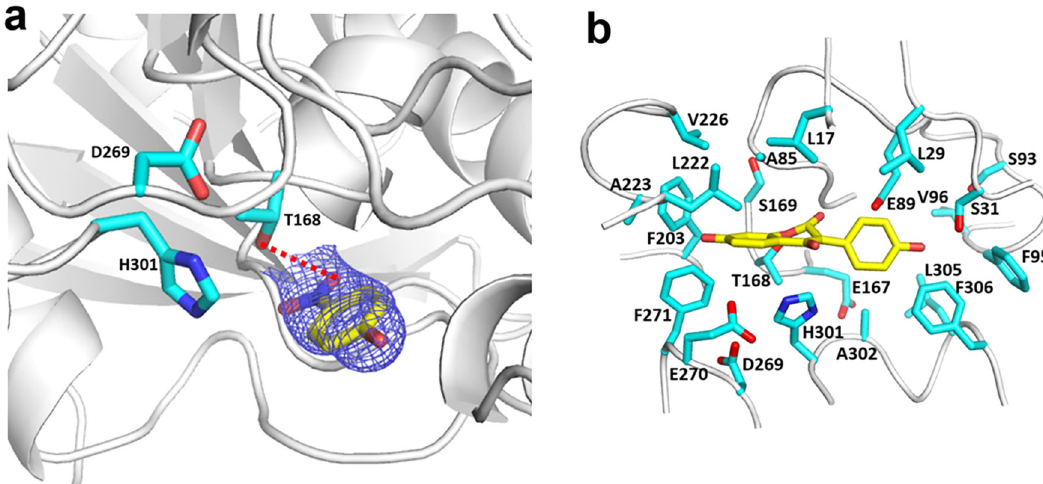
Fig. 9 Structural basis for dual functionality of 2-HID from P. lobata. a 2Fo-Fc electron density map at 1.0 σ for p -nitrophenyl (NPO) and a catalytic triad, Thr168, Asp269 and His301 for carboxylesterase activity; b Active site of 2-HID docked with substrate 2,7,4´-trihydroxyiso fl avanone close to the catalytic acid Glu89 and catalytic base His301. Key residues involved in substrate binding are shown as bond models and colored according to element: oxygen, red; nitrogen, blue; and carbon, cyan. NPO and 2,7,4 ’ -trihydroxyiso fl avanone are also shown as bond models with their carbon atoms in yellow.